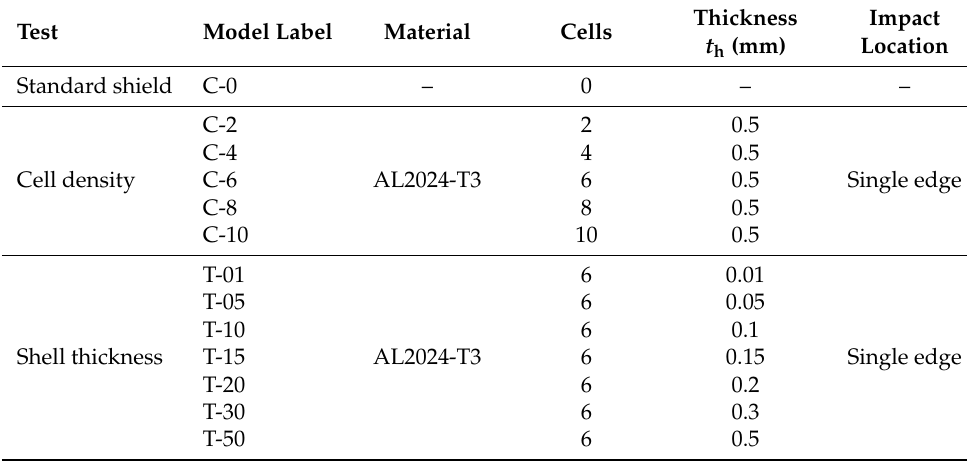
Table 2. Characteristics and labels of the developed Whipple shield numerical